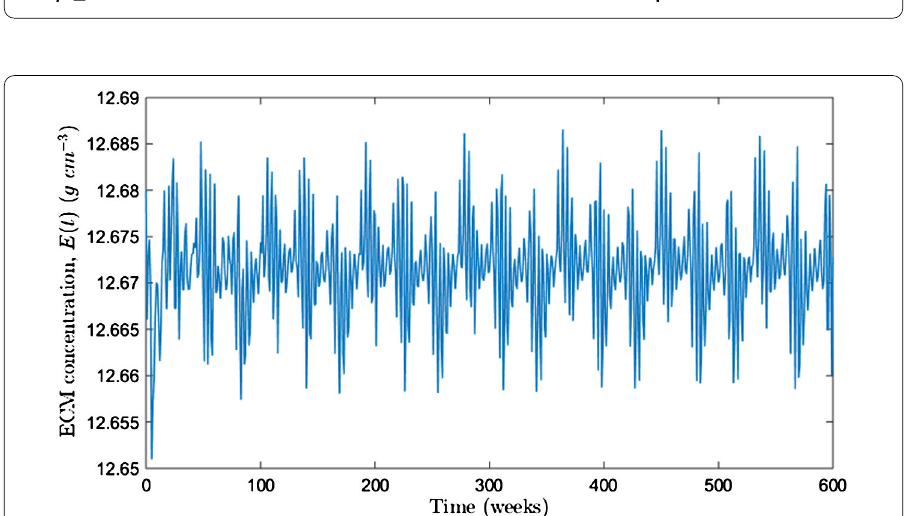
Figure 5 A simulated time course of EMC concentration when parametric values, given in Table 2, satisfy the conditions in Theorem 3 and the solution of (1)-(8) eventually oscillates